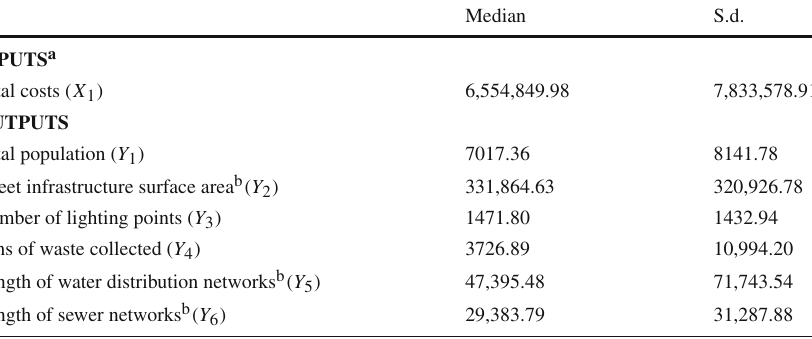
Table 5 Descriptive statistics for data in inputs and outputs, average values for the period